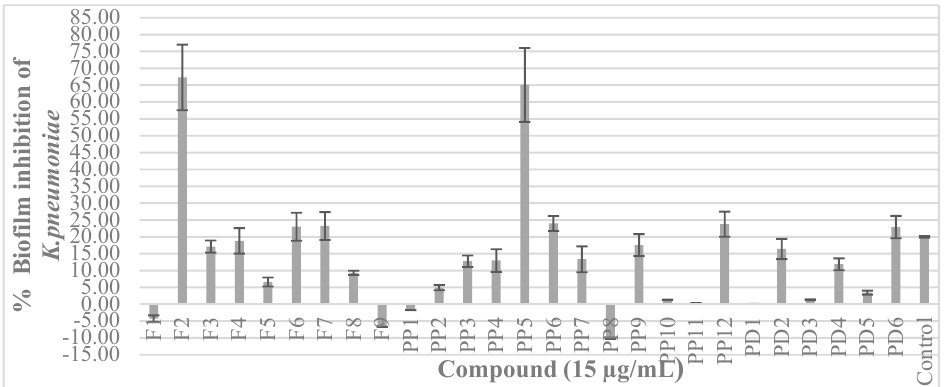
Figure 3. Effects of the compounds on the formation of the K. pneumoniae biofilm. The biofilm was obtained from an inoculum of K. pneumoniae in microplates of polystyrene and quantified by absorbance with violet crystal. In LB medium all substances were evaluated at 15 µg/mL (non-biocidal concentration). Negative values indicate a biofilm-inducing effect. See structure code in Figure 1.